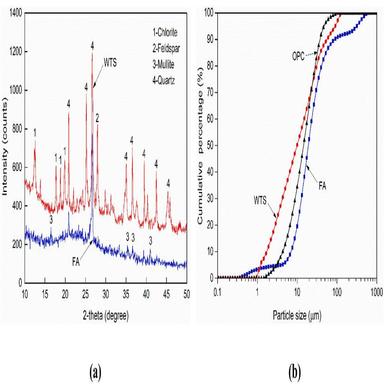
(a) XRD patterns and (b) grain size distributions of powder materials.